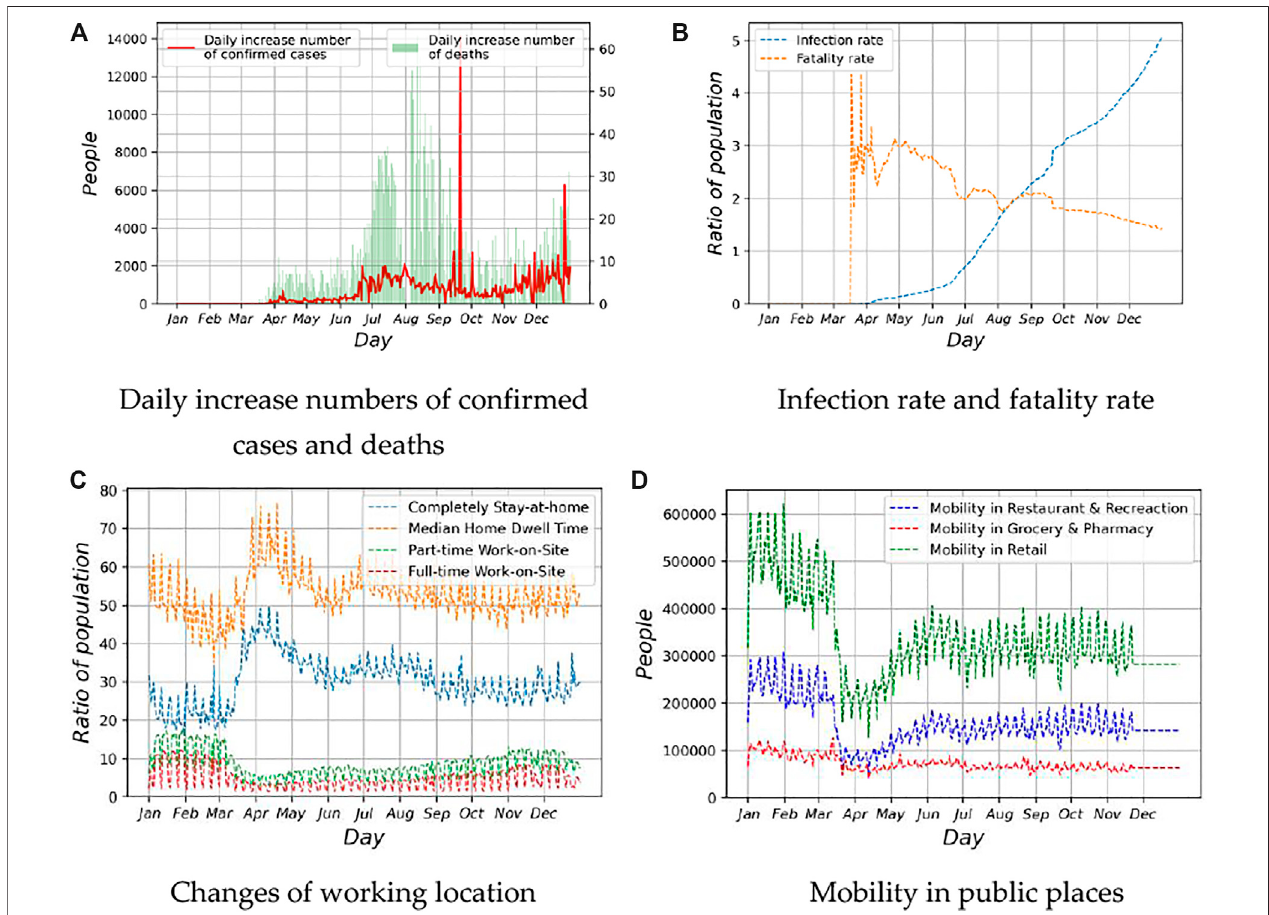
FIGURE12| COVID-19Statusandpeople ’ responseinHouston. (A) Dailyincreasenumbersofcon fi rmedcasesanddeaths; (B) Infectionrateandfatalityrate; (C) Changes of working location; (D) Mobility in public places.